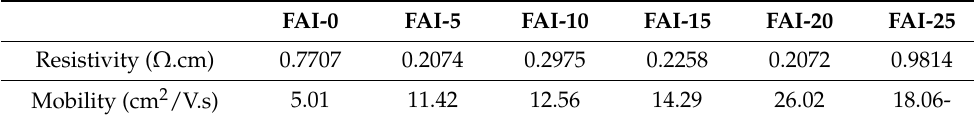
Table 1. Comparison of resistivity and mobility of FA x MA 1 − x PbI 3 films.